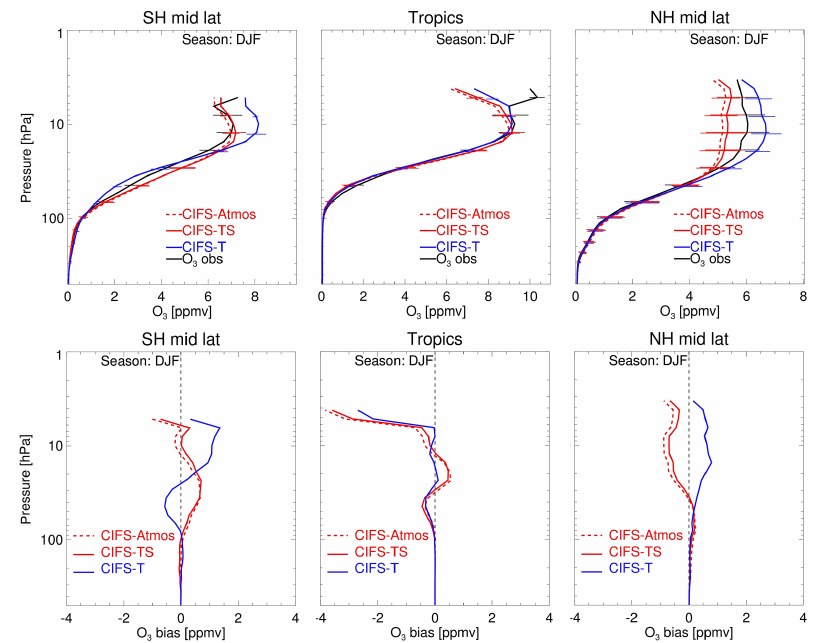
Figure 3. Top row: evaluation of ozone against WOUDC sondes over SH mid-latitudes (60–30 ◦ S, left), tropics (30 ◦ N–30 ◦ S, middle) and NH mid-latitudes (30–60 ◦ N, right) for December–January–February 2009 and 2010 in units ppmv. Black: WOUDC observations; red dashed: C-IFS-Atmos; red solid: C-IFS-TS; blue: C-IFS-T. Error bars denote the 1 σ spread in the models and observations. Bottom row: corresponding mean biases.